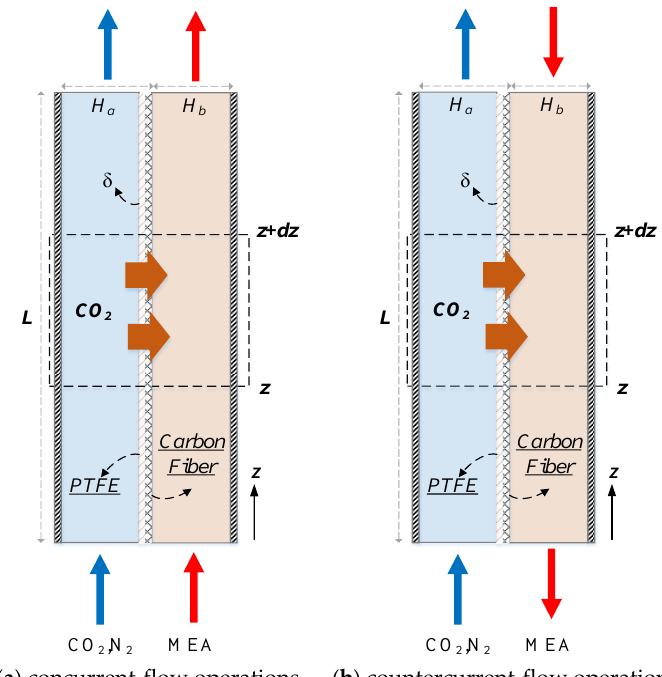
Figure 3. Schematic representation of CO 2 absorption by monoethanolamide (MEA) for concurrent- and countercurrent-flow operations in parallel-plate membrane gas–liquid contactors. ( a ) concurrent-flow operations; ( b ) countercurrent-flow operations.